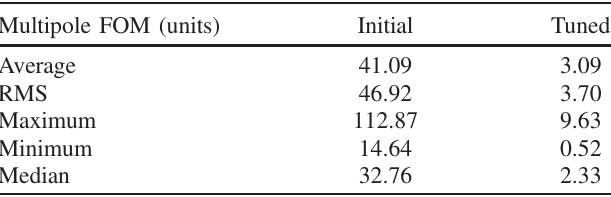
TABLE V. CBETA scaled figure of merit statistics.